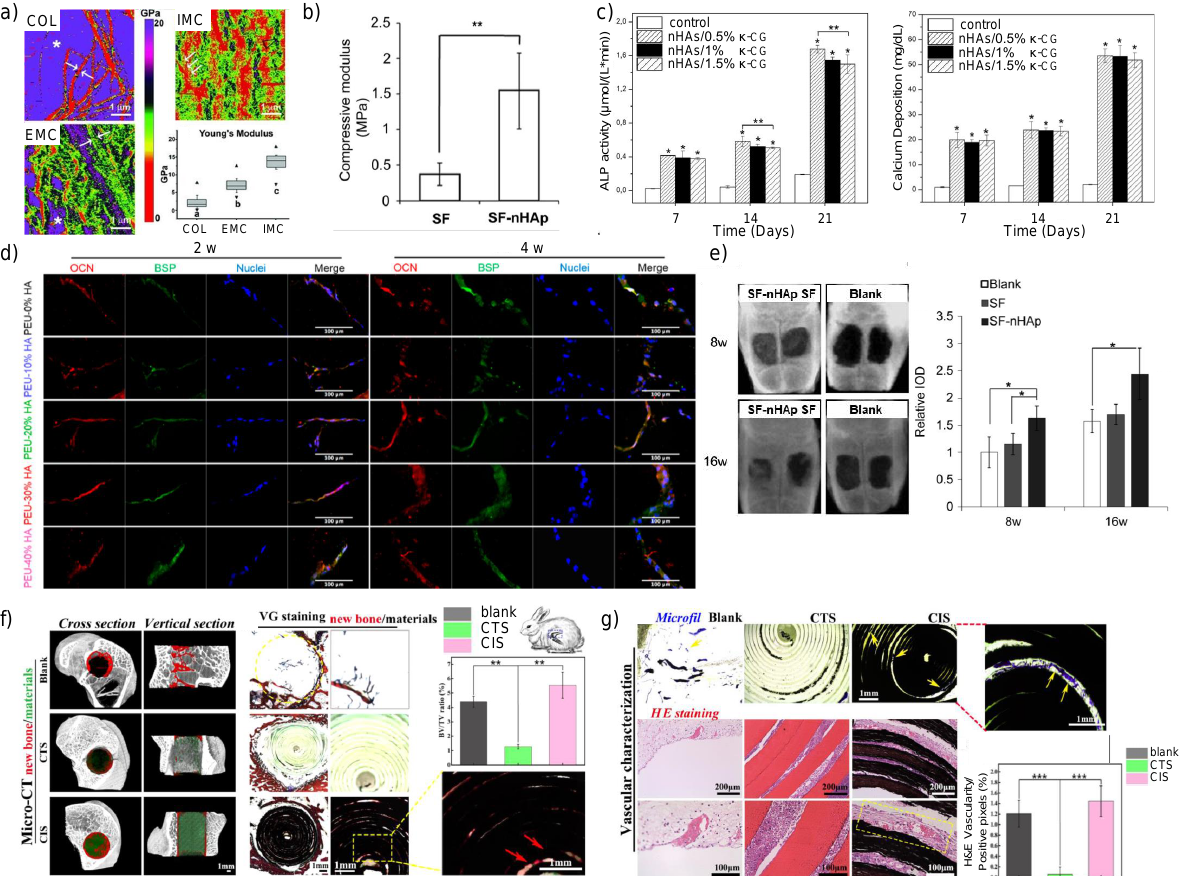
Figure 2. The mechanical and biological properties of nHA/polymer composites. ( a ) The highly ordered deposited nano hydroxyapatites (nHAs) provided intrafibrillarly mineralized collagen (IMC) with much higher Young’s modulus than that of pure collagen (COL) and extrafibrillarly mineralized collagen (EMC) [16]. ( b ) The addition of nHAs increased the compressive modulus of silk fibroin significantly [22]. ( c ) nHA/kappa-carrageenan ( κ -CG) enhanced the alkaline phosphatase (ALP) activity and calcium deposition of human osteoblasts, regardless of the concentration of κ -CG [28]. ( d ) With the increase of nHAs content, the MC3T3-E1 preosteoblast cells expressed more osteocalcin (OCN) and bone sialoprotein (BSP) [24]. ( e ) The nHA/silk fibroin composites promoted the bone regeneration in rat calvarial defects [22]. The co-inspired scaffold (CIS) which consisted of nHAs and chitosan induced both new bone formation ( f ) and vascularization ( g ) compared with blank and pure chitosan [29]. *: p < 0.05, **: p < 0.01, ***: p <